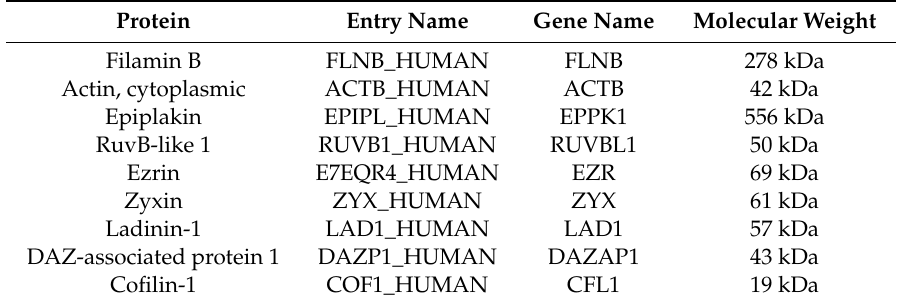
Table 1. FLNA-binding proteins identified by immunoprecipitation using FLNA-specific antibodies and mass spectrometric